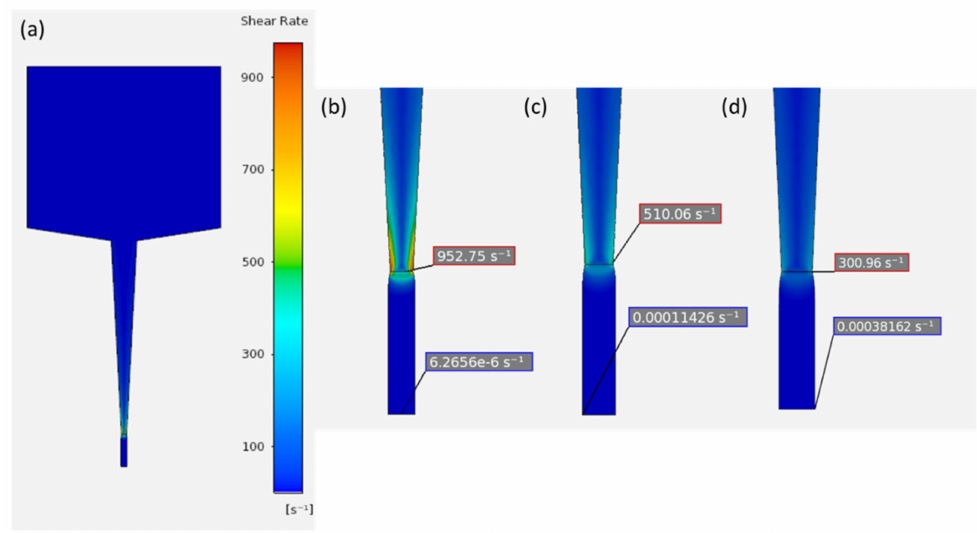
Figure 10. Simulated shear rate (1/s) distribution of the rice paste with different nozzle sizes: ( a ) fluid domain, ( b ) nozzle size 0.8 mm, ( c ) nozzle size 1.0 mm, and ( d ) nozzle size 1.2 mm.